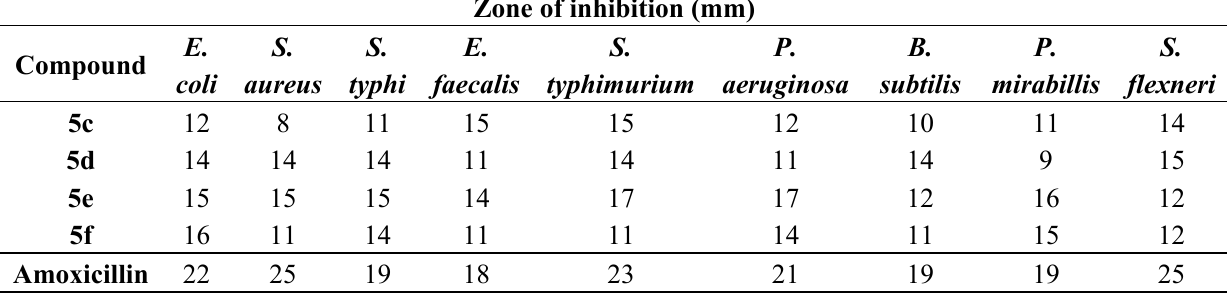
Table 2. Cont . Zone of inhibition (mm)